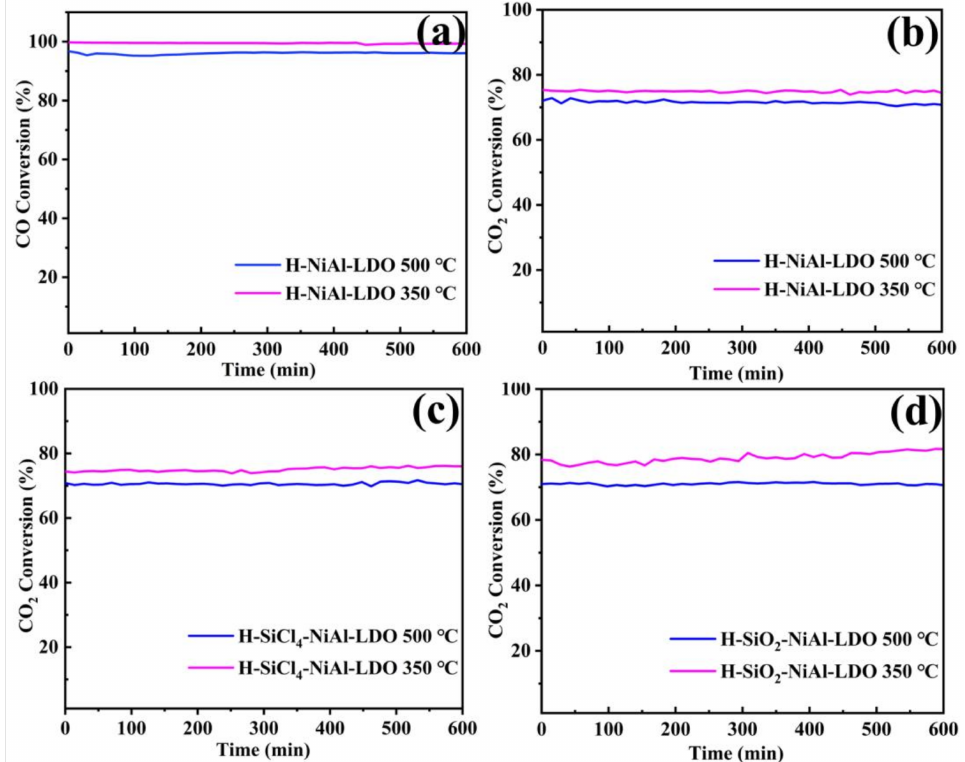
Figure 7. ( a – d ) The 10 h CO/CO 2 methanation performance of each